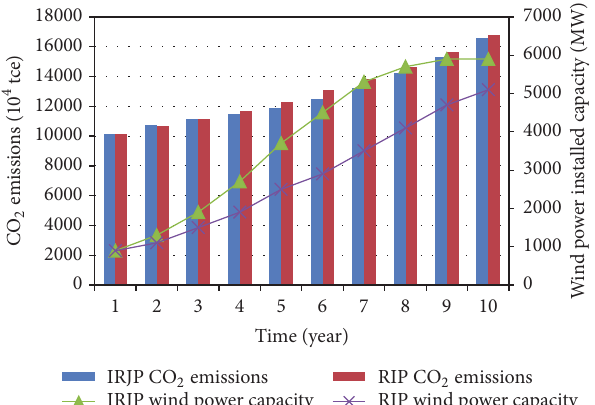
Figure 3: Wind power installed capacity and CO 2 emission by joint planning and independent planning.